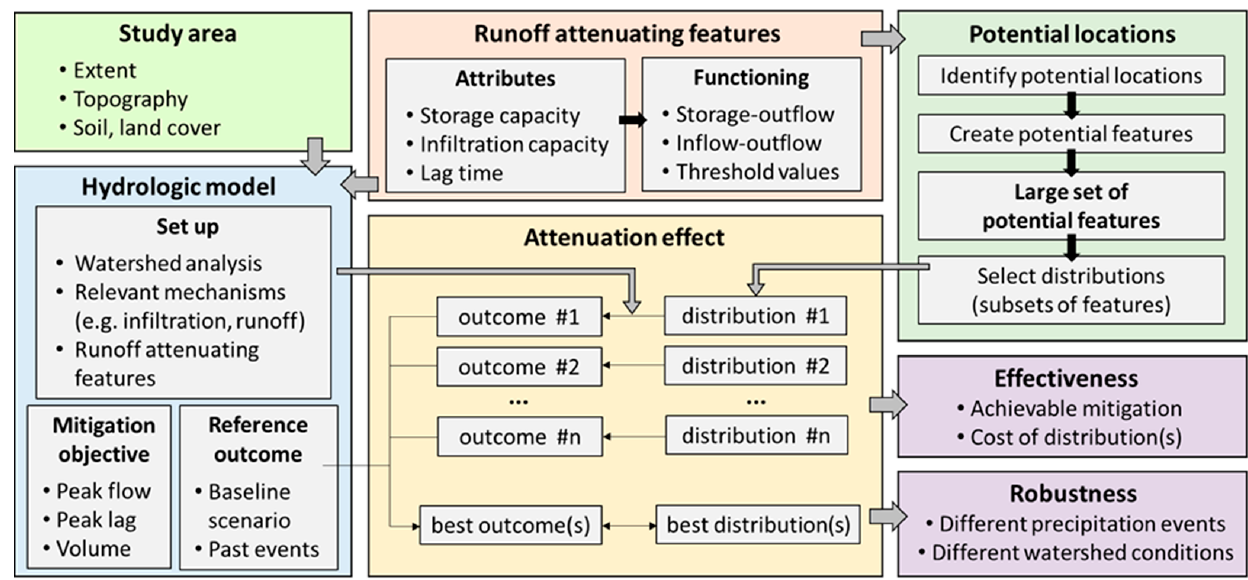
Figure 1. Proposed framework for studying the effect of distributed runoff attenuating features.